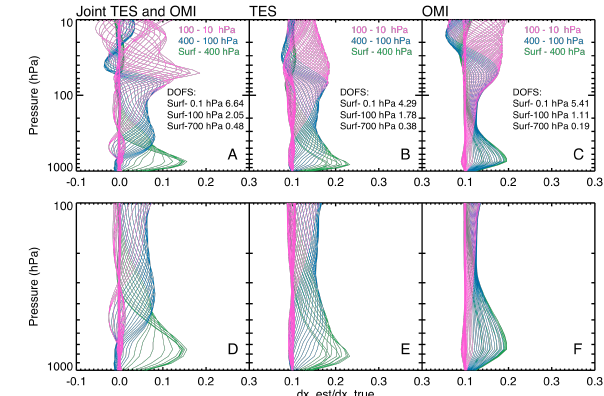
Figure 1 . Examples of averaging kernels for the measurement over Naha, Okinawa, Japan on 2 Fig. 1. Examples of averaging kernels for the measurement over August 1 st , 2007: (A) Joint TES and OMI measurement; (B) TES measurement; (C) OMI 3 Naha, Okinawa, Japan, on 1 August 2007: (A) Joint TES and OMI measurement; (D, E, F) zoom-in view of averaging kernels from surface to 100 hPa. In each 4 measurement; (B) TES measurement; (C) OMI measurement; (D, panel, averaging kernels in three altitude ranges are shown in color curves: surface to 400 hPa 5 E, F) zoom-in view of averaging kernels from surface to 100hPa. in green; 400 to 100 hPa in blue; 100 to 10 hPa in magenta. For Joint TES/OMI 6 In each panel, averaging kernels in three altitude ranges are shown measurements, TES alone and OMI alone, DOFS in the altitude of surface to 700 hPa is 0.29, 7 in color curves: surface to 400 hPa in green; 400 to 100hPa in 0.13, 0.10 respectively; in the altitude of surface to 100 hPa is 2.21, 1.84, 1.16 respectively; in 8 blue; and 100 to 10hPa in magenta. For Joint TES/OMI measure- the altitude of surface to 0.1 hPa is 6.98, 4.47, 5.61 respectively. 9 ments, TES alone and OMI alone, DOFS in the altitude of surface to 700hPa is 0.29, 0.13, 0.10, respectively; in the altitude of surface to 100hPa is 2.21, 1.84, 1.16, respectively; and in the altitude of surface to 0.1hPa is 6.98, 4.47, 5.61, respectively.